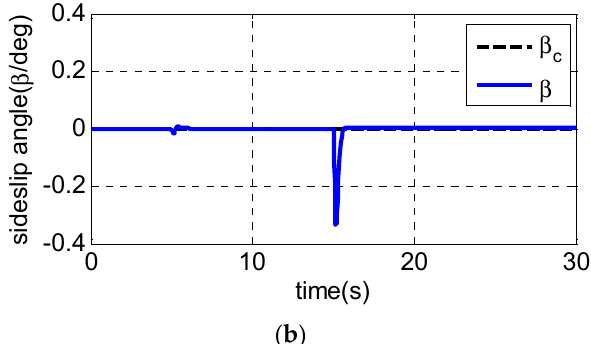
Figure 5. Simulation results of attack angle and sideslip angle: ( a ) attack angle and ( b ) sideslip angle.